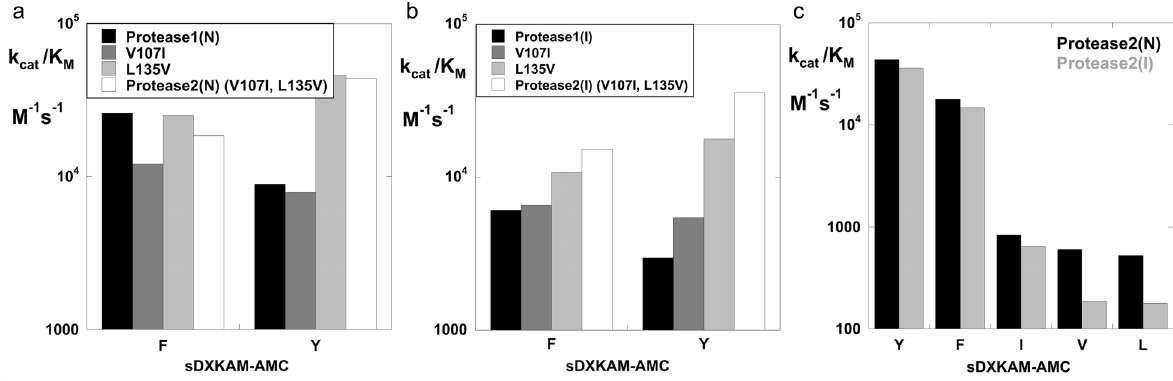
Fig. 2 k cat / K M as a function of mutation in the P4 pocket. a Protease1(N) variants in 1 mM nitrite. b Protease1(I) variants in 10 mM imidazole. c Comparison of P4 speci fi city for Protease2(N) in 1 mM nitrite and Protease2(I) in 10 mM imidazole for the fi ve highest activity